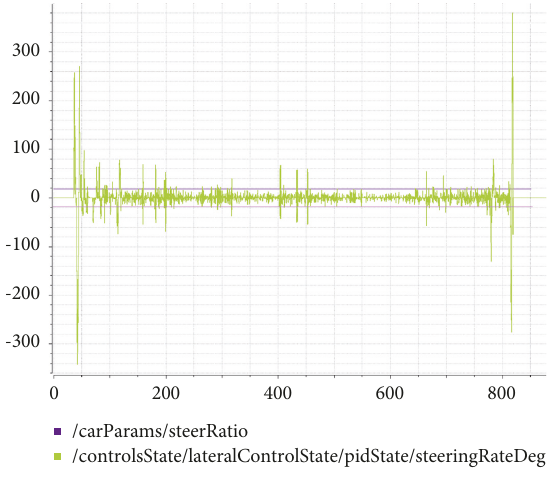
Figure 15: T1D3 steering degrees.